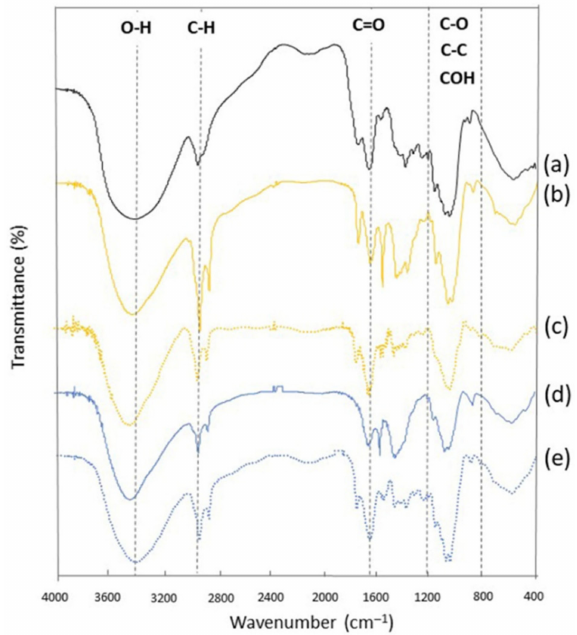
Figure 4. Fourier transform infrared (FTIR) spectra of commercially available BG ( a ), BG obtained from S. cerevisiae Kyokai NO. 9 by alkaline ( b ) and enzymatic ( c ) recovery, BG obtained from K. marxianus TISTR 5925 by alkaline ( d ) and enzymatic ( e )